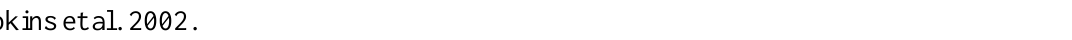
Table 1 . Perceptions of constraints to cross-scale linkages for participatory resource management among regulators and resource users in Tobago, 1999-2001. Organizational areas Perceived problems Operational Inadequate staff trained in integrated and inclusive approaches. Inadequate full-time outreach staff. Few successful examples of integrated and inclusive approaches. Over-use of external consultants. Structural Information hoarding. Inadequate public access to information. Project-driven approaches impose project cycle and